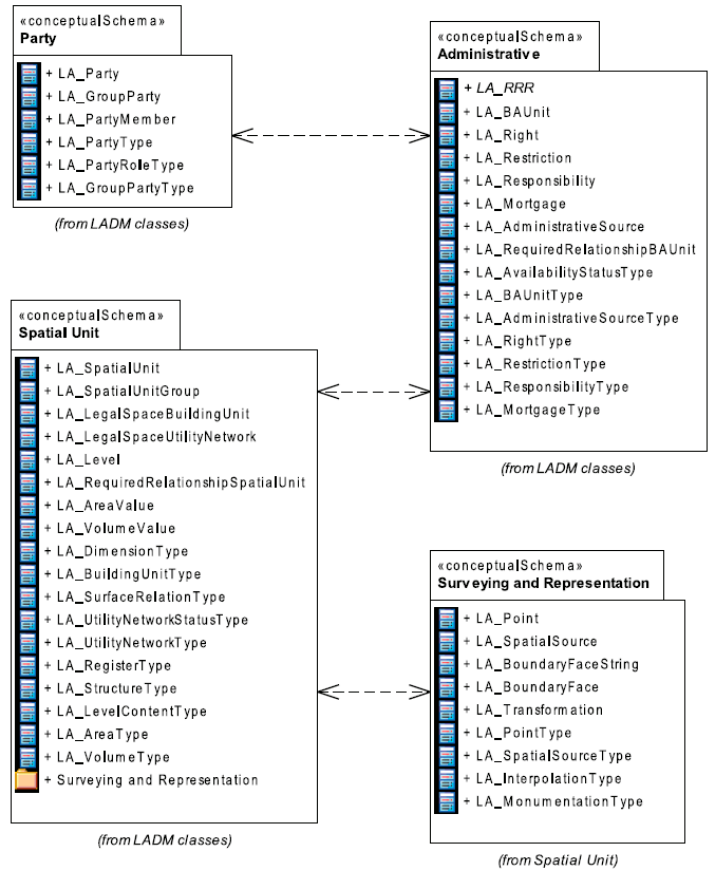
Figure 3. Packages of LADM standard, adapted from [24] (p. 8).